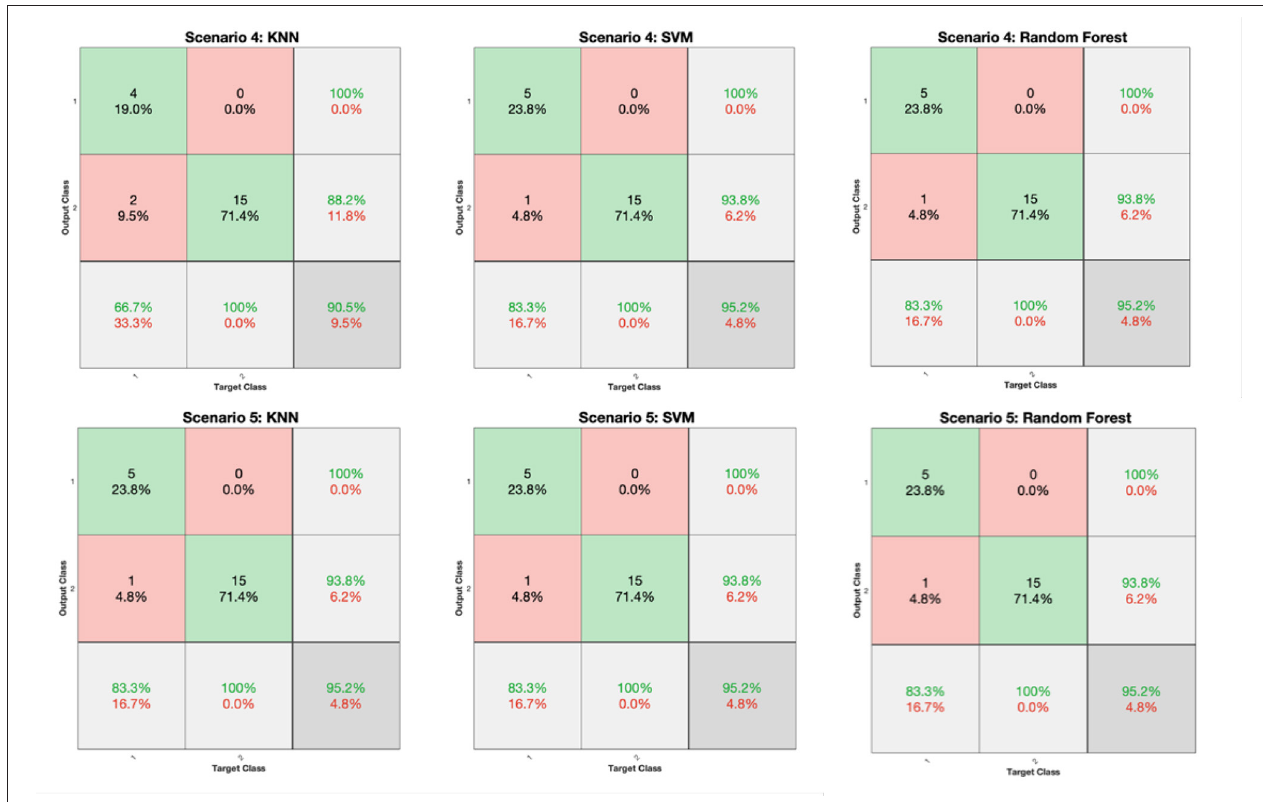
FIGURE 7 | Confusion matrices generated from the KNN, SVM, and RF classifiers for the FV scenarios of 4 and 5 ( Table 3 ).